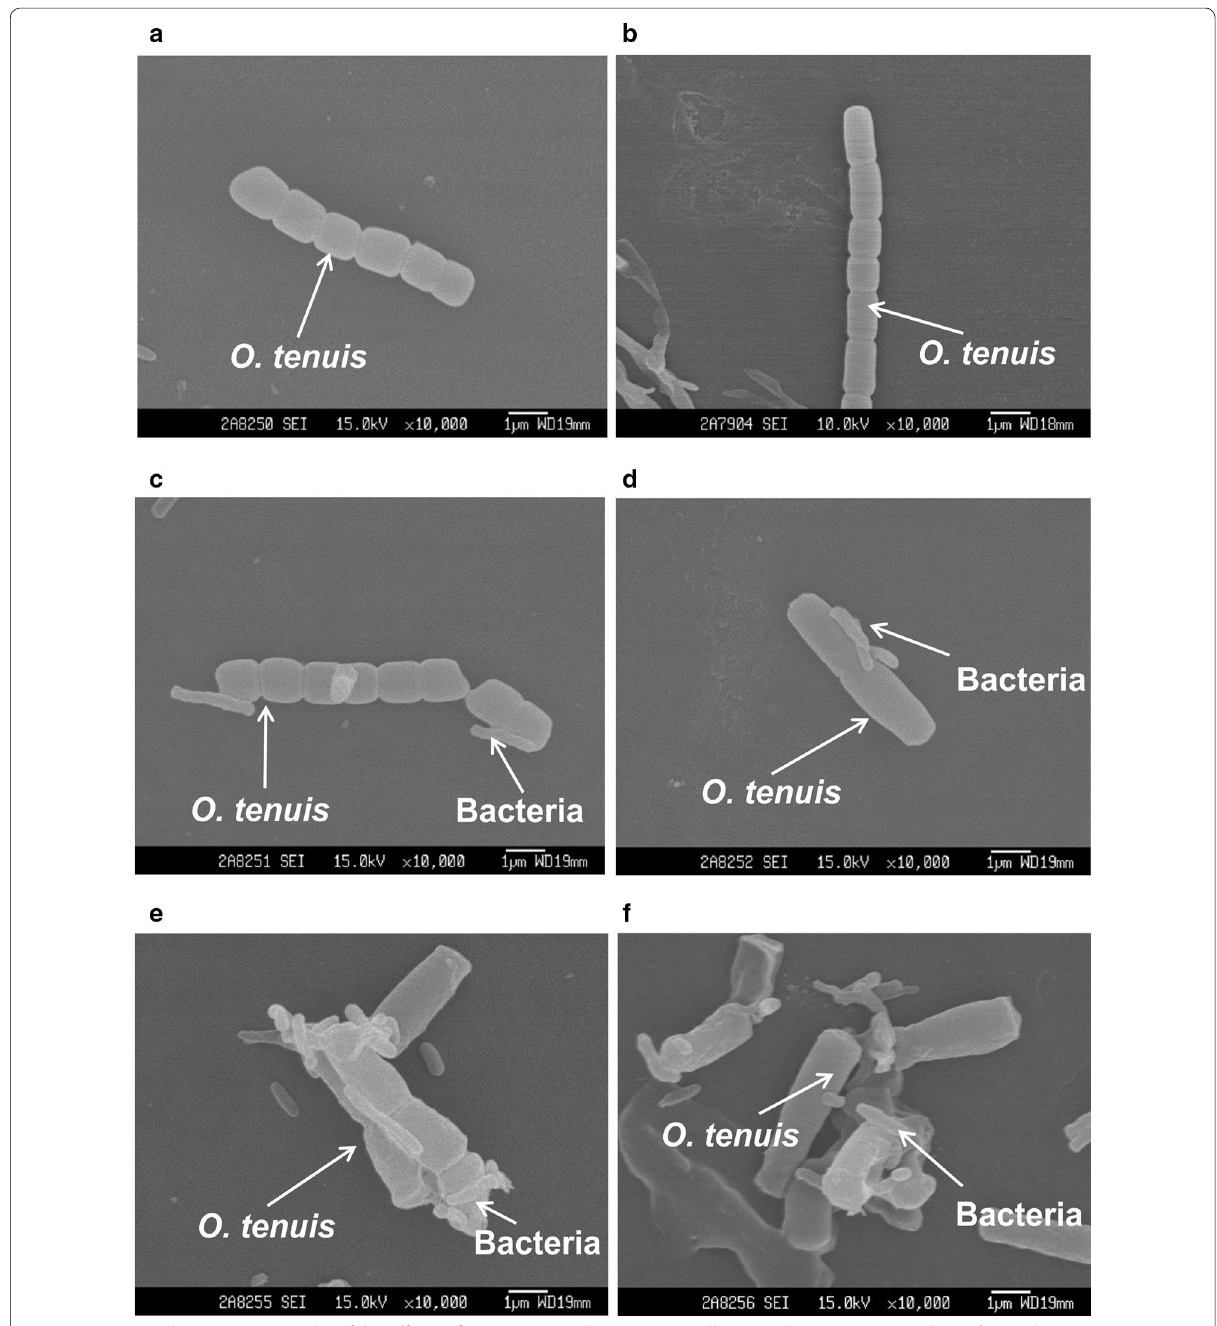
Fig. 4 Scanning electron micrographs of the effects of CZBC1 on Oscillatoria tenuis cells. a Initial stage in Ot‑C and Ot‑F. b Initial stage in Ot‑B. c Early stage of alginolysis in Ot‑B. d Middle stage of alginolysis in Ot‑B. e , f Late stage of alginolysis in Ot‑B. Ot‑C: O. tenuis control group; Ot‑B: O. tenuis bacterial suspension group; Ot‑F: O. tenuis sterile filtrate + +